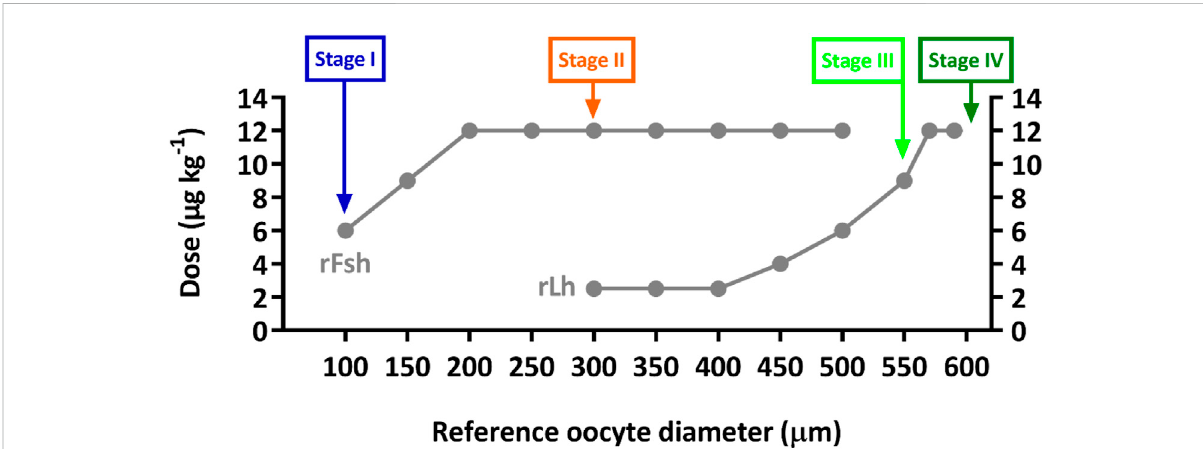
FIGURE 1 GraphicalrepresentationoftherecombinantgonadotropinhormonaltreatmentfromRamos-Júdezetal.(2021),identifyingthepointsatwhich ovarian samples were collected by cannulation from fi ve fl athead grey mullet females. Stage I, before rGth treatment from initial arrested gonad; Stage II, after 4 weeks of increasing doses of rFsh (from 6, 9 – 12 μ g kg − 1 ); Stage III, after combined treatment with 12 μ g kg − 1 rFsh and